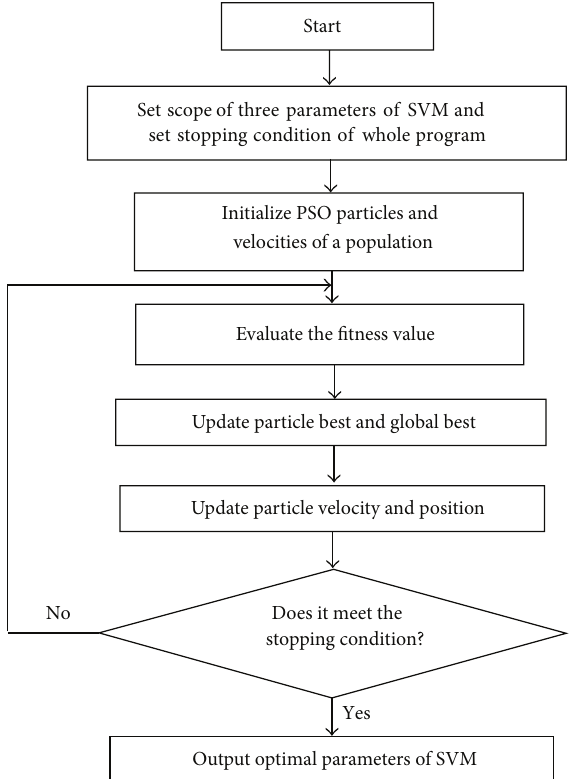
Figure 1: The process of optimizing the SVM parameters with